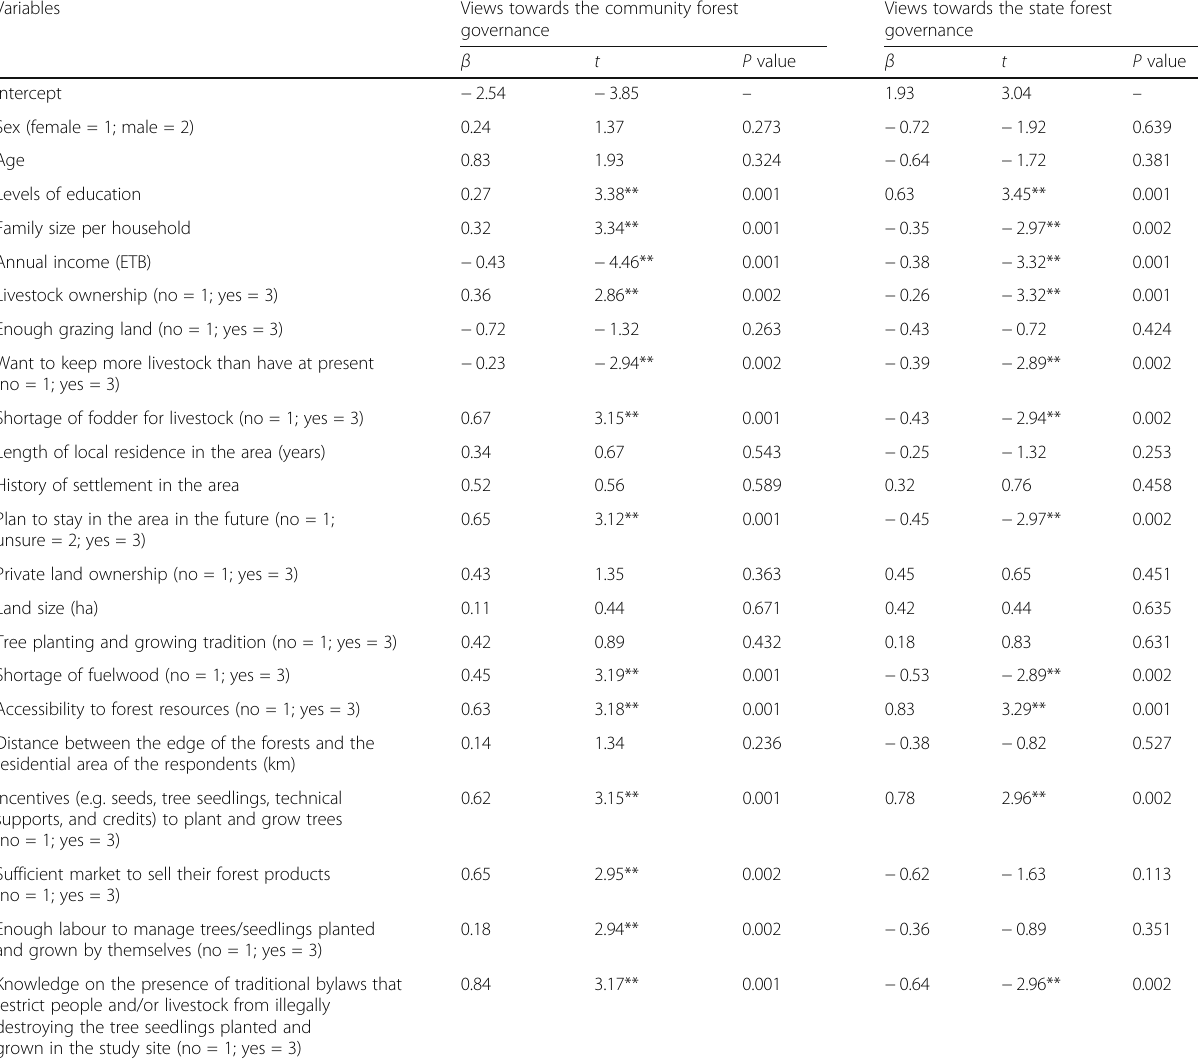
Table 2 Multiple linear regression model to predict the views of local people towards the community forest governance, and the state forest governance in Tehulederi District Variables Views towards the community forest Views towards the state forest governance